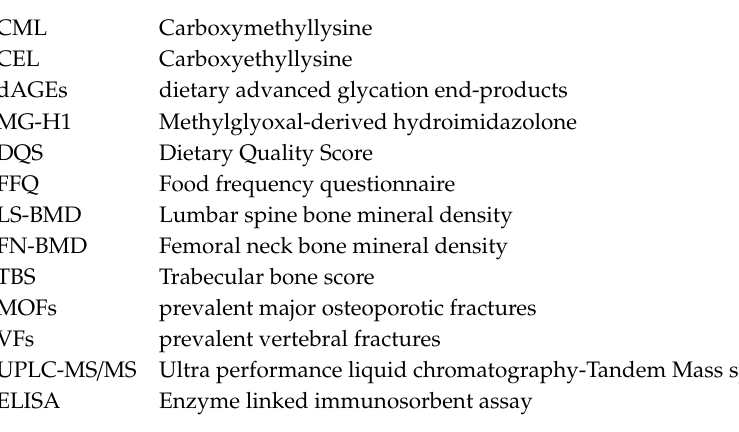
Table S1: Odds ratio (ORs) of energy-adjusted CML for MOF and VFs in non-type 2 diabetics (non-T2DM), diabetics (T2DM), females and males in N = 3949 subset with complete data on all covariates. Table S2: Odds ratio (ORs) of energy-adjusted total dAGE score, CEL and MG-H1 as a continuous variable and quartiles (Q1-4) for MOFs and VFs in total